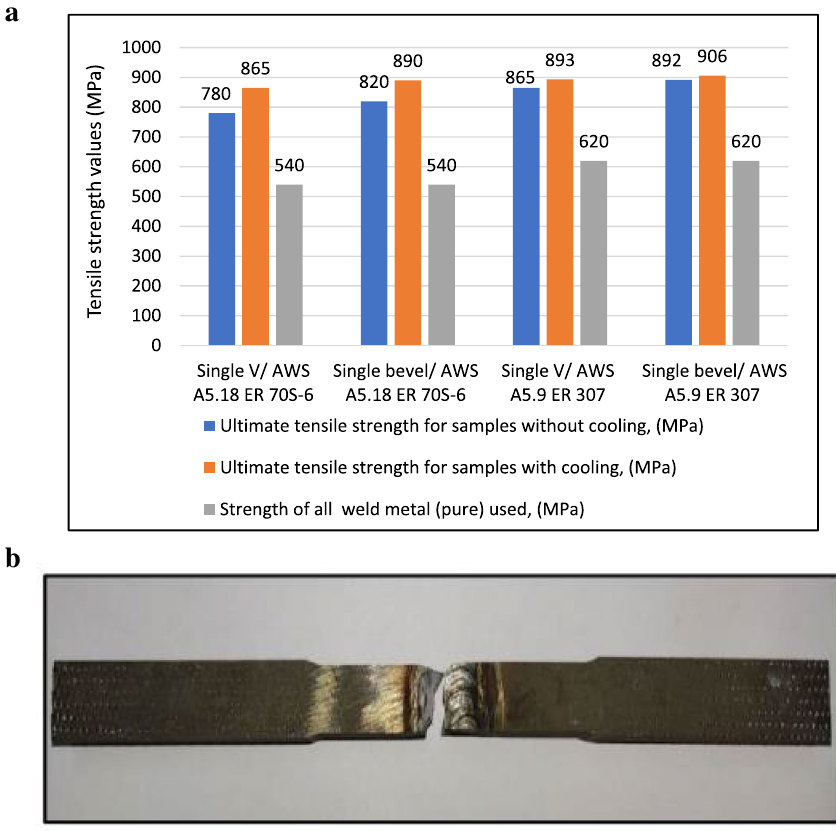
Fig. 12 a Tensile strength of welded joints. b Fracture location of the tensile test specimens